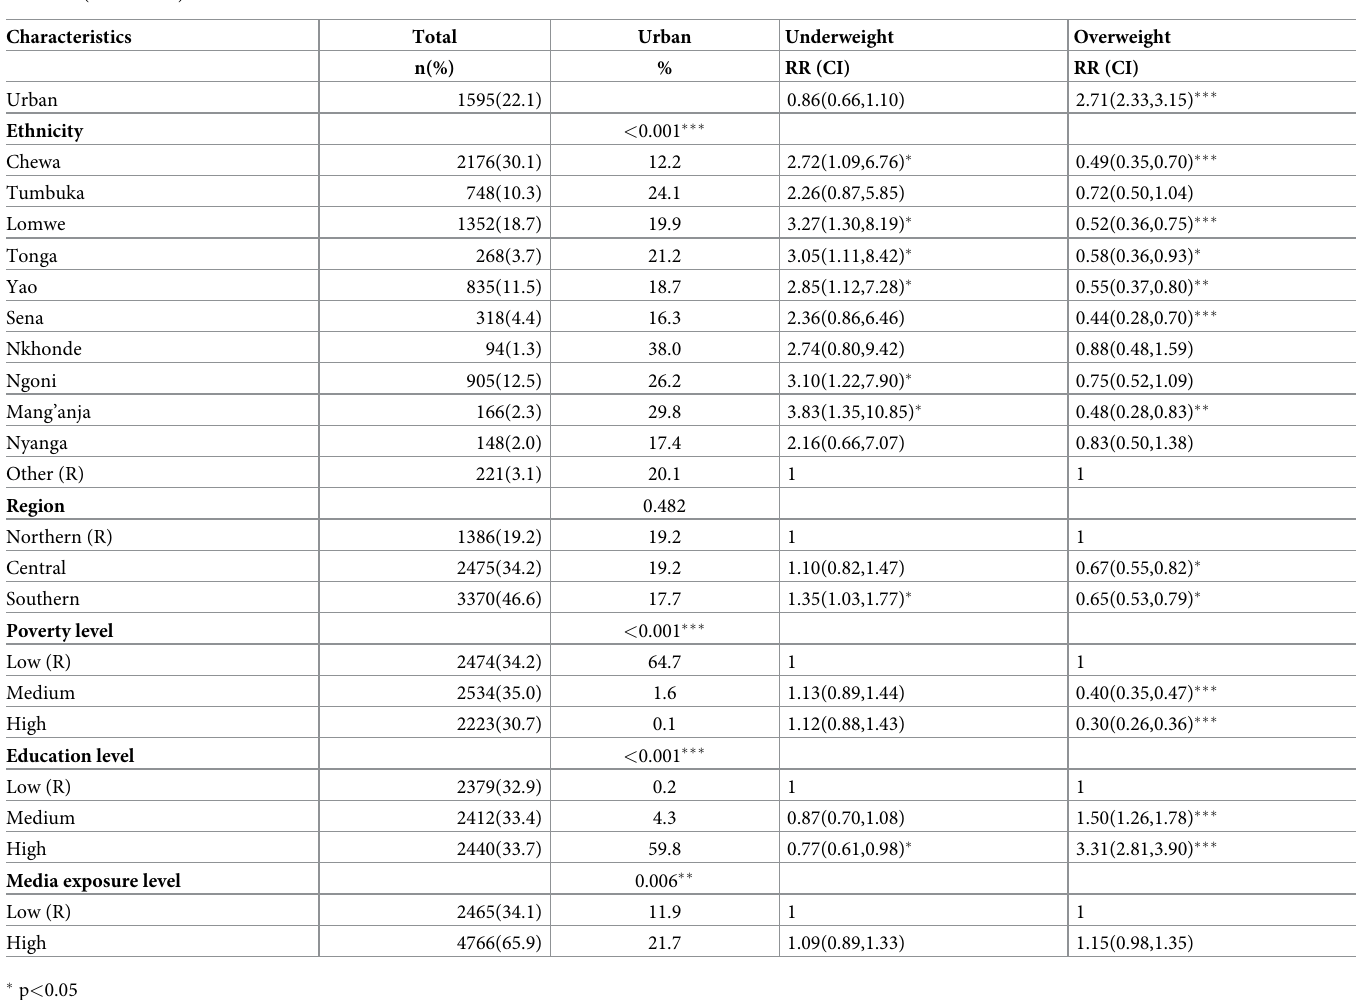
Adjusted models’ fixed effects. Table 2 presents the results of the four models which include individual- and community-level fixed effects along with random effects. Considering the favoured (final) model, only the highest educational attainment, marital status and ethnic- ity remained significantly associated with the relative risk of being underweight over healthy weight (panel 1; Model-3). The risk of being underweight decreased with increasing highest educational attainment such that the risk of underweight was 86% lower among women who had higher education (aRR: 0.14; CI: 0.03–0.59) than no formal education. Similarly, ever mar- ried women (currently—aRR: 0.37; CI: 0.27–0.50; formerly—aRR: 0.46; CI: 0.32–0.66) had lesser risks of being underweight relative to healthy weight. However, Chewa (aRR: 2.53;